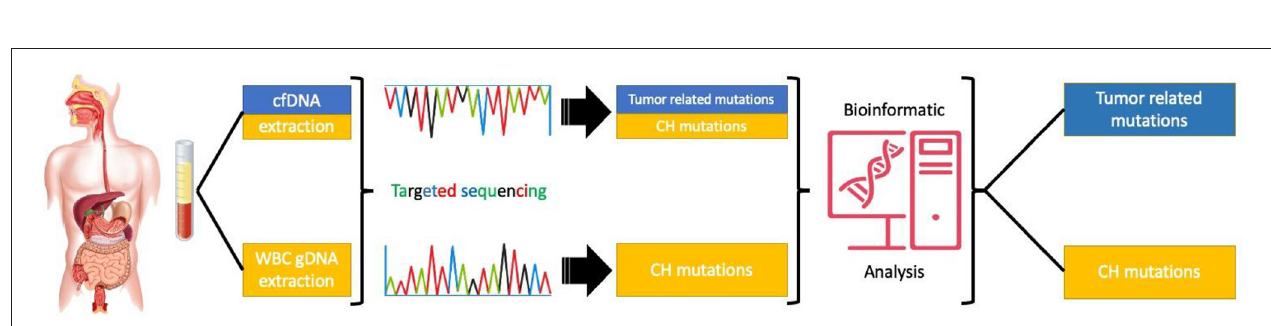
Frontiers in Medicine |